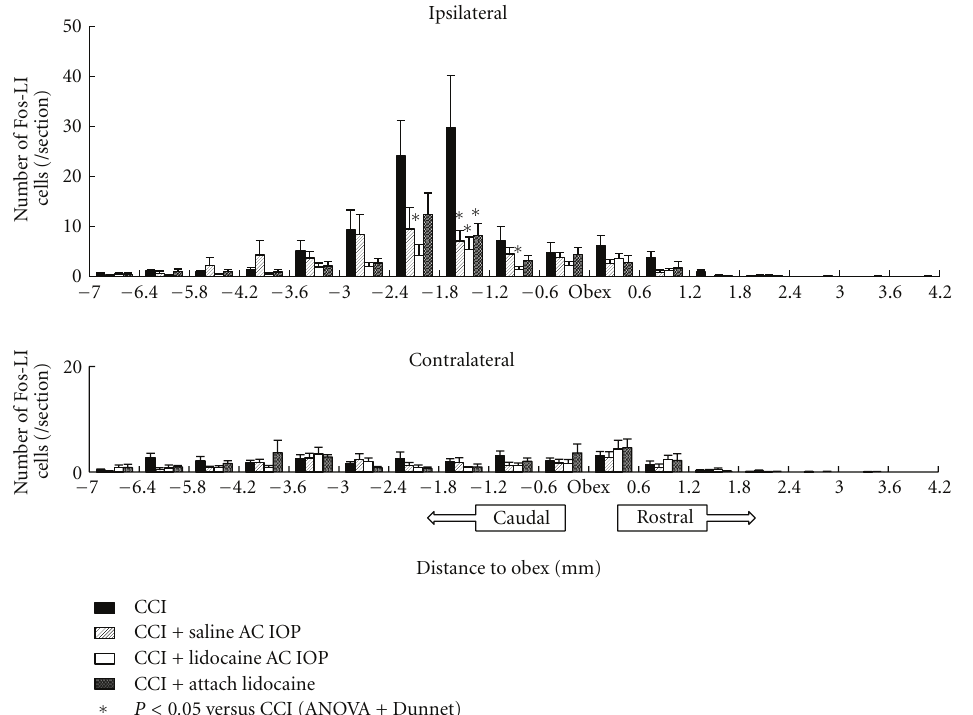
Figure 5: Distribution of the expression of Fos-LI cells in the trigeminal nucleus. The CCI + lidocaine AC IOP group showed a decrease in the number of Fos-LI cells from − 2.4 mm to − 0.6 mm in the trigeminal nucleus. The number of Fos-LI cells decreases from − 1.8mm to − 1.2mm in the trigeminal nucleus of the CCI + saline AC IOP group and the CCI + attach lidocaine group. No significant di ff erence in the number of Fos-LI cells was observed on the contralateral side. ∗ P < 0 . 05, n = 5.